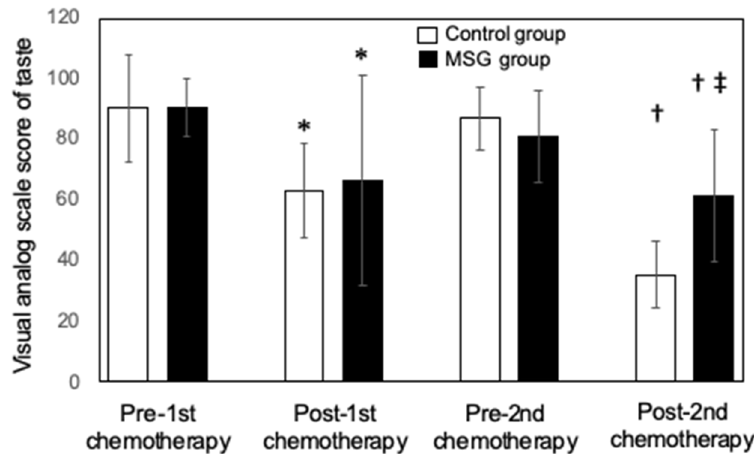
Figure 2. Effect of dietary monosodium glutamate (MSG) supplementation on chemotherapy-induced taste impairment in patients with head and neck cancer. The visual analog scale (VAS) score of taste sensitivity was measured in patients randomly assigned to the control ( n = 26) and MSG ( n = 25) groups immediately before and 1 week after the first and second doses of chemotherapy. Data are represented as the mean ± standard deviation. * p < 0.05 vs. the corresponding value for pre-first chemotherapy, † p < 0.05 vs. the corresponding value for pre-second chemotherapy, ‡ p < 0.05 vs. the corresponding value for the control group. Multiple comparison was performed by the Kruskal–Wallis test and two-way ANOVA analysis of variance. If an overall significant difference was detected, the Tukey–Kramer test was applied to identify pairs showing significant differences.